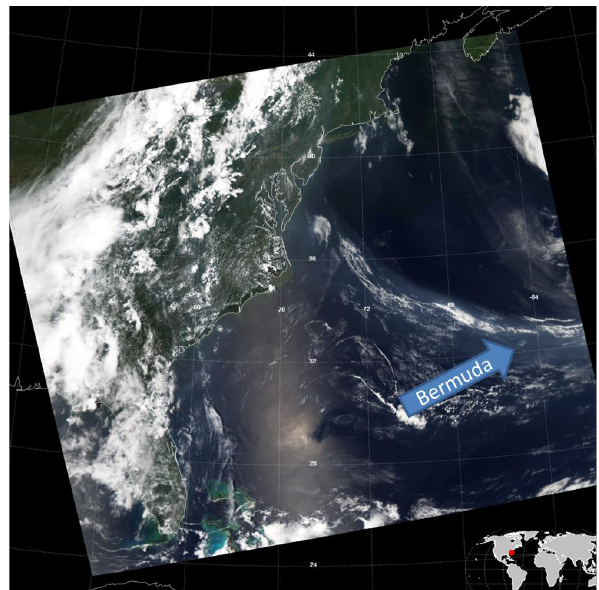
Figure 8. Fig. 8. MODIS Aqua true color image from 19 June 2007, midpoint of the three day polluted haze/biomass burning event with high scat- tering, absorption, nss SO 2 − , OC, and EC transported from North 4 and East-SEUS on 18, 19 and 20 June 2007 as a frontal boundary advanced toward Bermuda from the